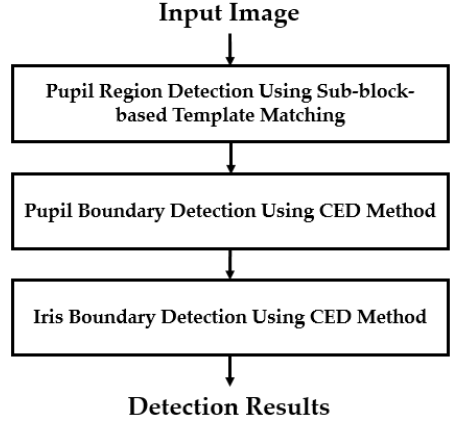
Figure 2. Flowchart of iris segmentation method in our study.